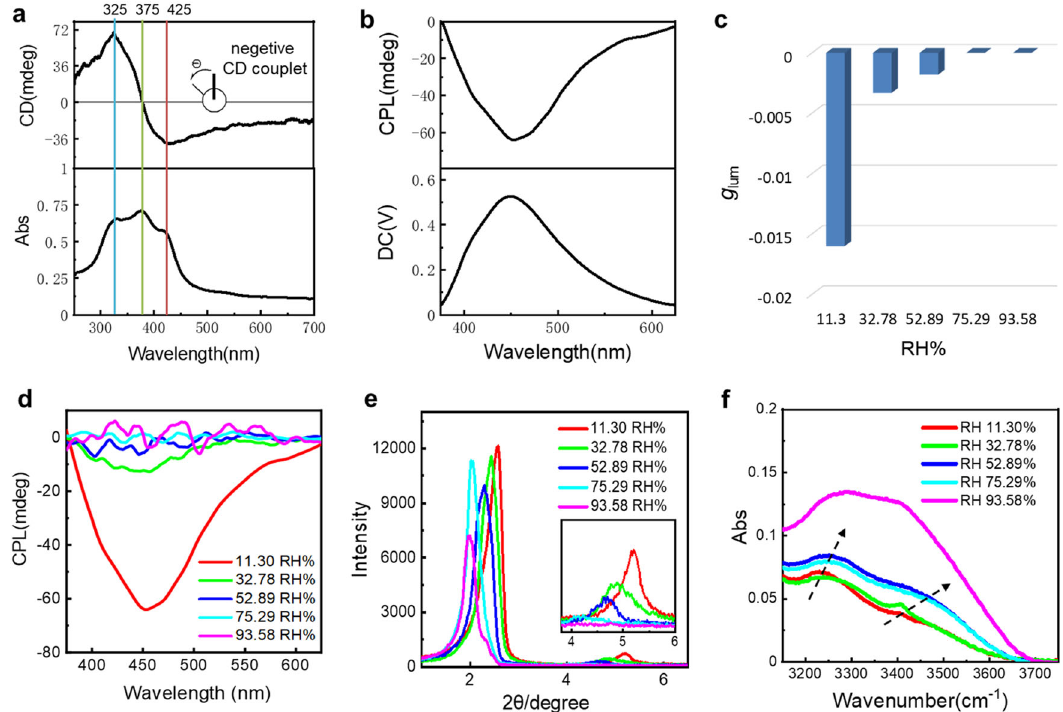
Fig. 3 Humidity responsiveness of the clusterization triggered emission (CTE)-based circularly polarized luminescence (CPL). a Circular dichroism (CD) and ultraviolet – visible (UV – vis) spectra and b CPL spectra ( λ ex = 330 nm) of PLL-OL fi lm (relative humidity (RH): 11.30%). c Emission dissymmetry factor g lum value, d CPL spectra ( λ ex = 330 nm), e XRD patterns, and f FT-IR (Fourier transition-inferred) spectra of the PLL-OL fi lm at different relative